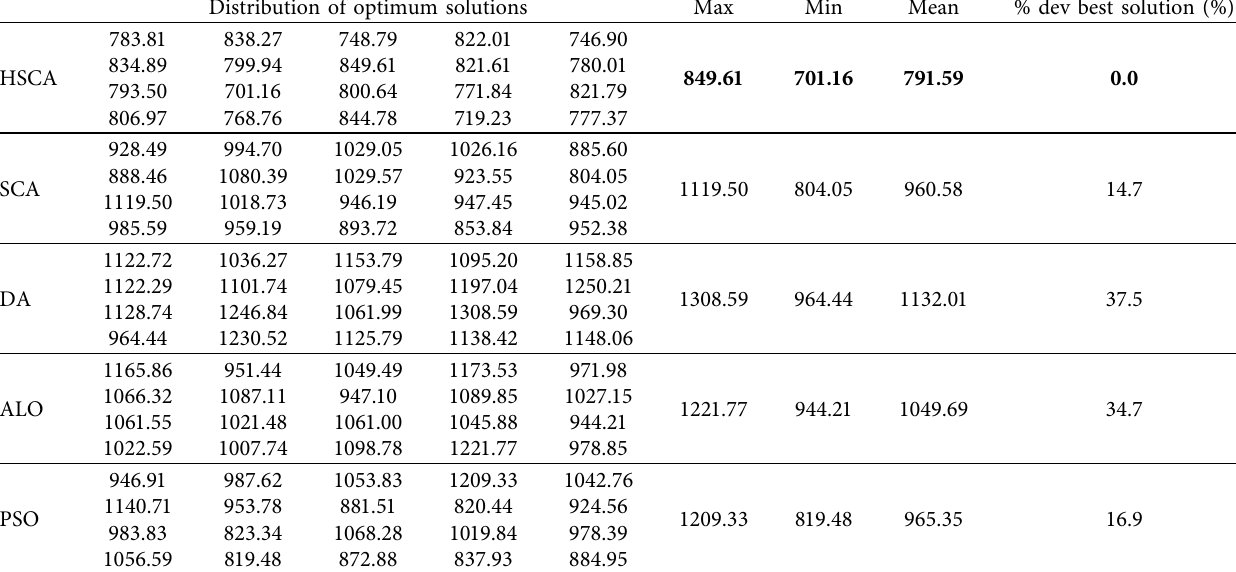
Table 5: Best solutions obtained with diferent algorithms after 20 runs in case study